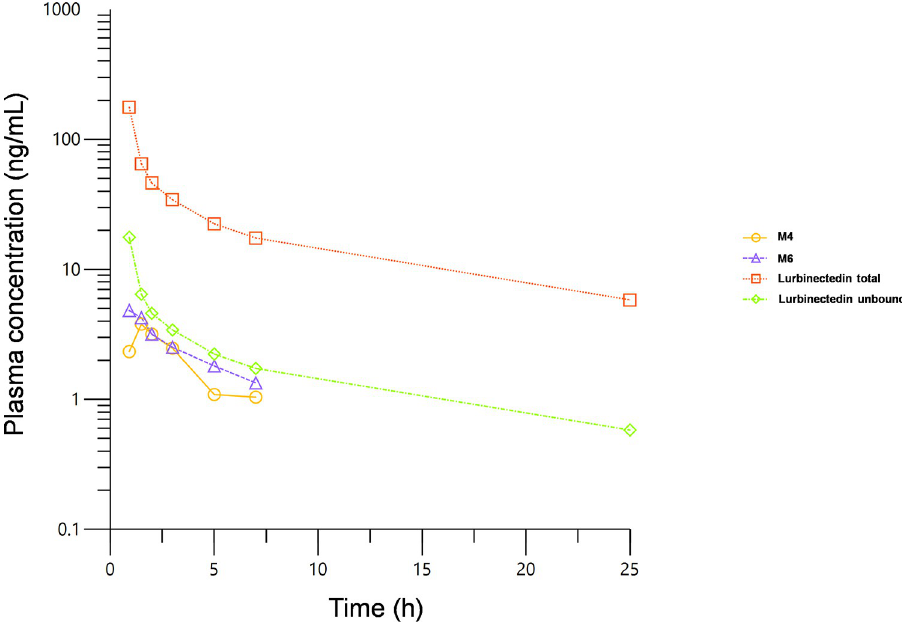
Fig 7. Total and unbound lurbinectedin and M4 and M6 plasma concentration-time profiles of an individual patient treated in study A-019.